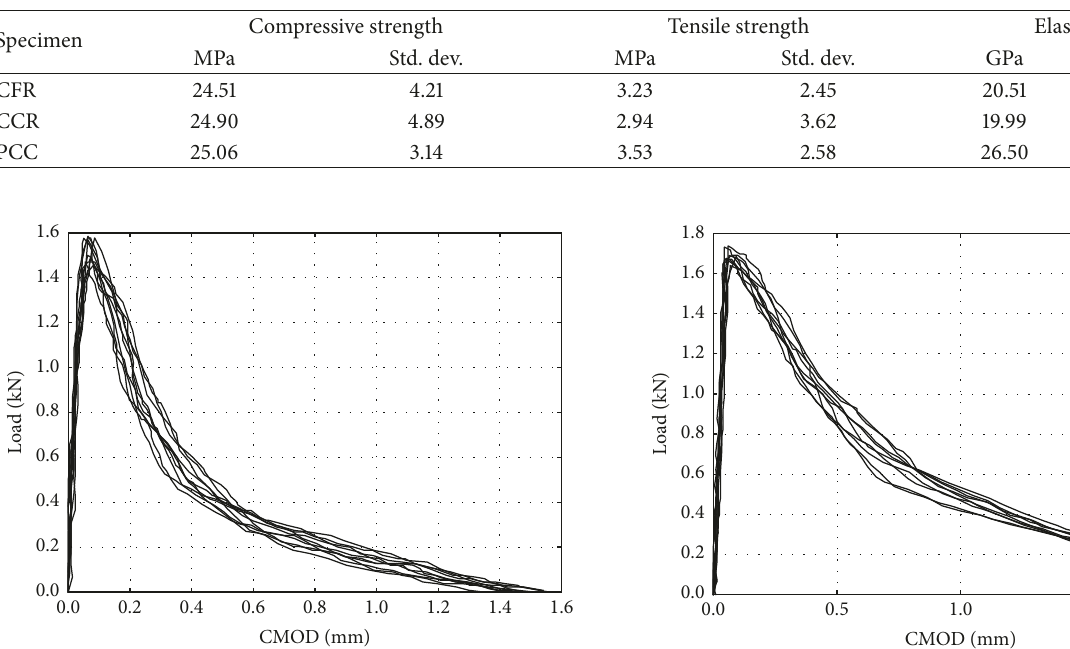
Figure 7: Fracture energy for CFR.